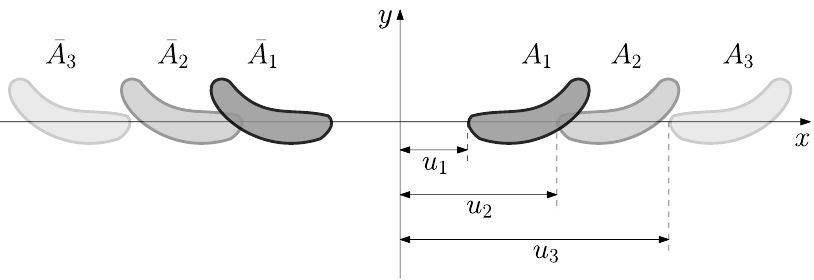
Figure 2 . Some representatives of the family of regions located in the right Rindler wedge and their re(cid:13)ections. Each region in the right Rindler wedge is obtained by a translation in x of the same region. The RMI between A i and (cid:22) A j depends only on the distance u i + u j between these